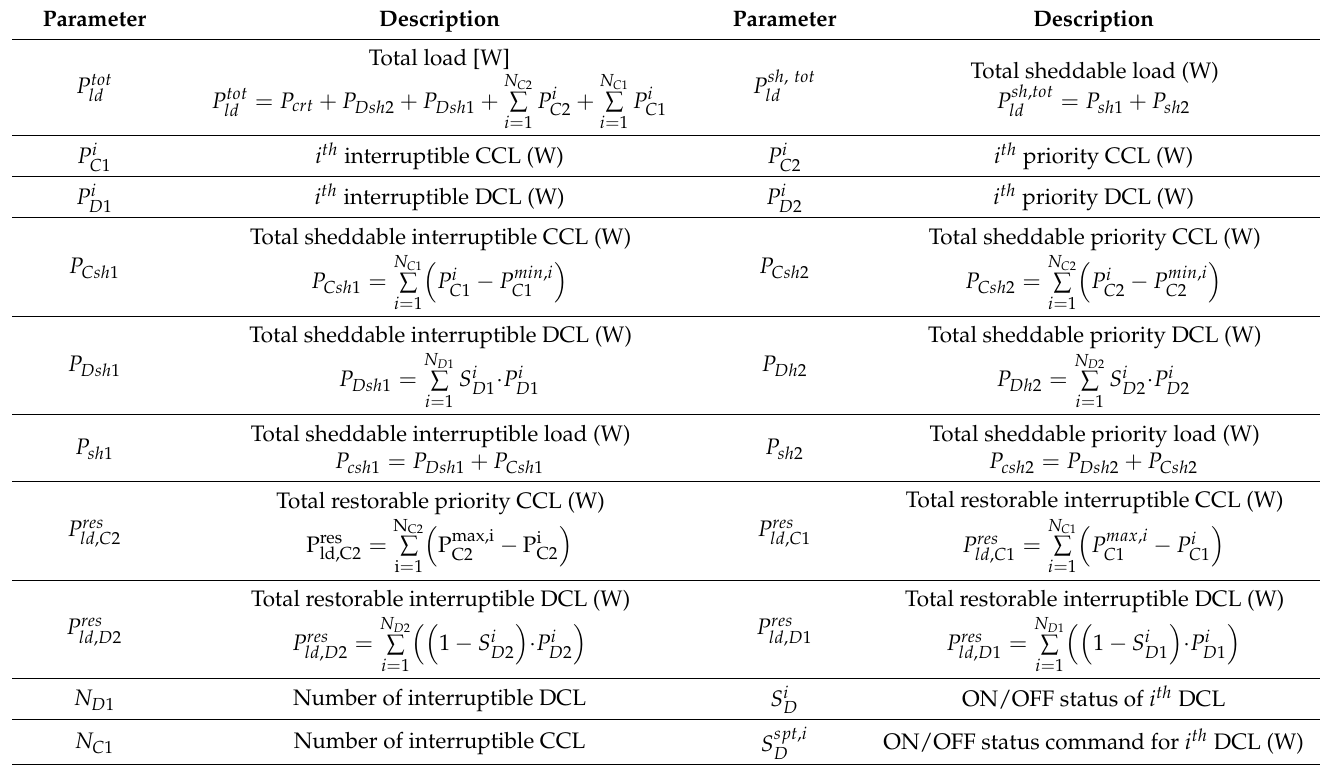
Figure 7. Control modes considering SOC ranges: ( a ) SOC ranges [26]. ( b ) Control mode allocation algorithm. Table 3. Parameter related to the load management